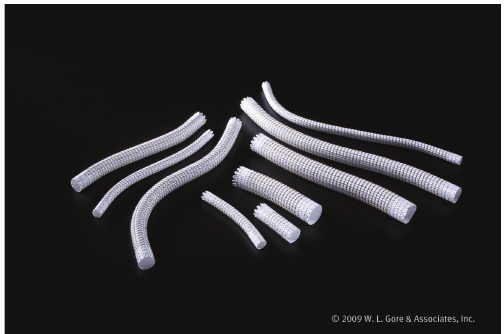
Figure 1: Viabahn PET covered stents. Picture provided by W. L. Gore and Associates.